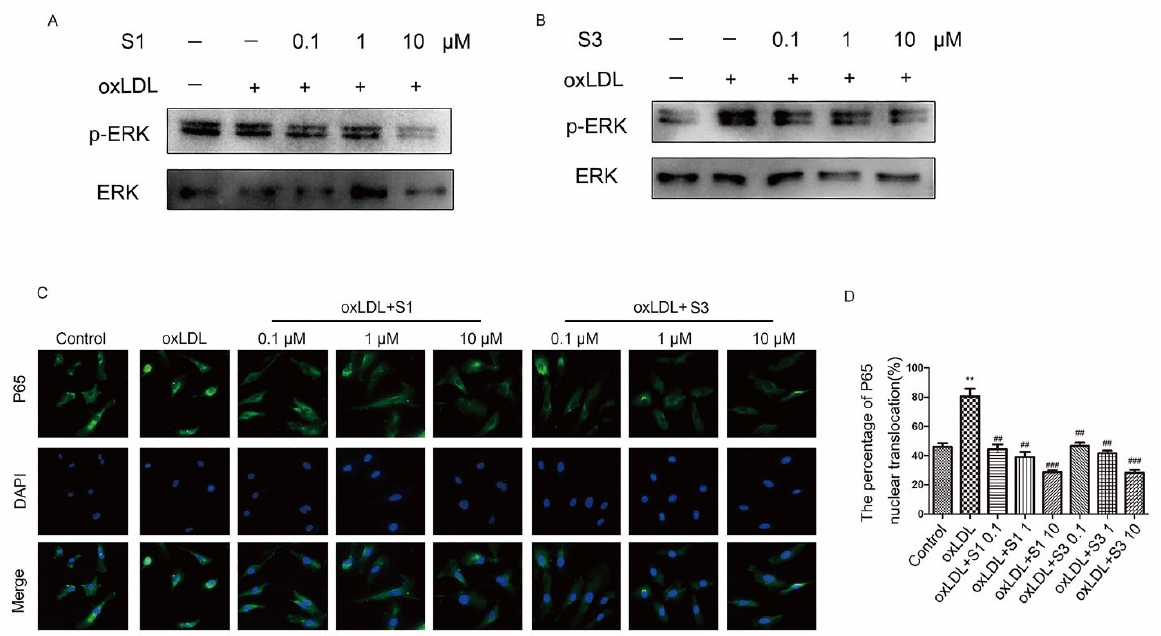
Figure 6. Effect of compounds S1 and S3 on the phosphorylation of ERK and NF- κ B nuclear translocation in oxLDL-treated HUVECs. HUVECs were treated with oxLDL (50 µ g/mL), oxLDL and indicated compounds for 6 h. ( A , B ) Representative Western blot analysis of pERK and ERK of 3 independent experiments.( C ) Fluorescent micrographs showed the distribution of NF- κ B p65 in HUVECs (200 × ). ( D ) Quantification of NF- κ B p65 nuclear translocation. Data were analyzed using one-way ANOVA with Bonferroni correction. ** p < 0.01 vs. control, ## p < 0.01, ### p < 0.001 vs. oxLDL, n = 3.